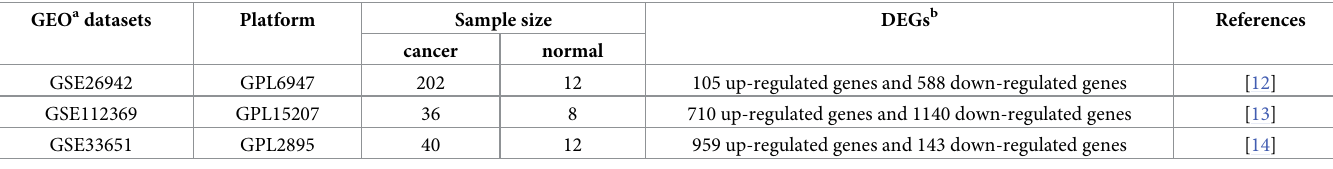
Table 1. The characteristics of three GEO datasets about gene expression profiling by array. GEO a